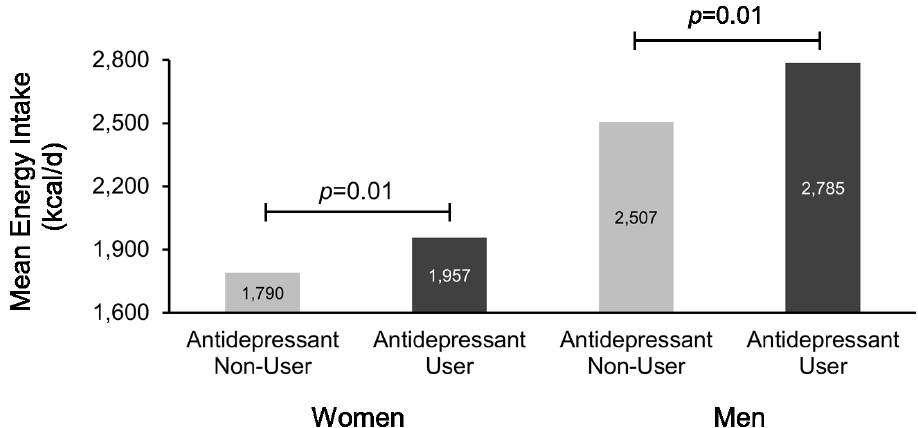
Figure 1. Antidepressant use is associated with increased energy intake (kcal/day) among adult men and women in the 2005–2006 National Health and Nutrition Examination Survey. Adjusted for